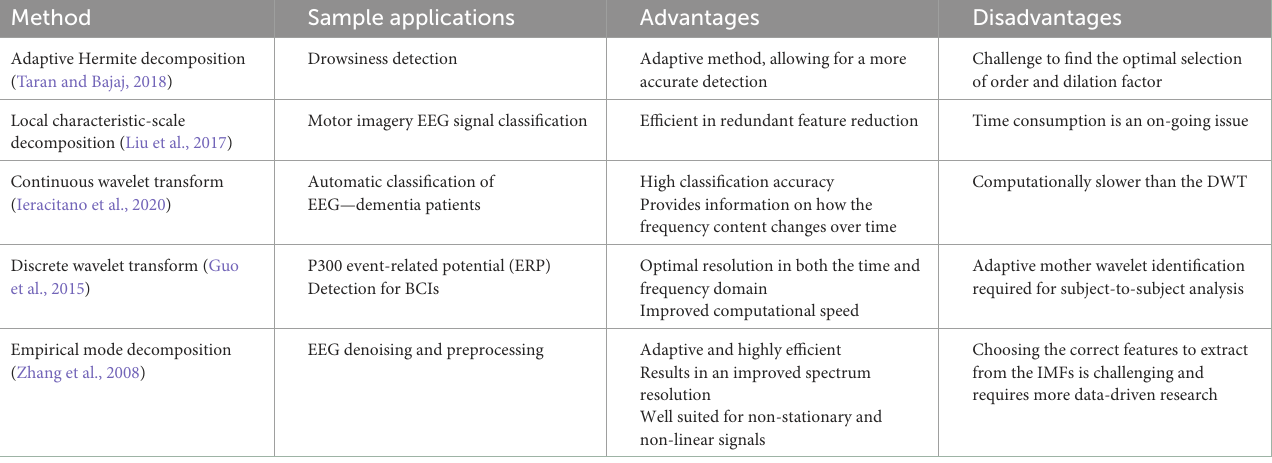
TABLE 3 Summary of decomposition-domain feature extraction methods for